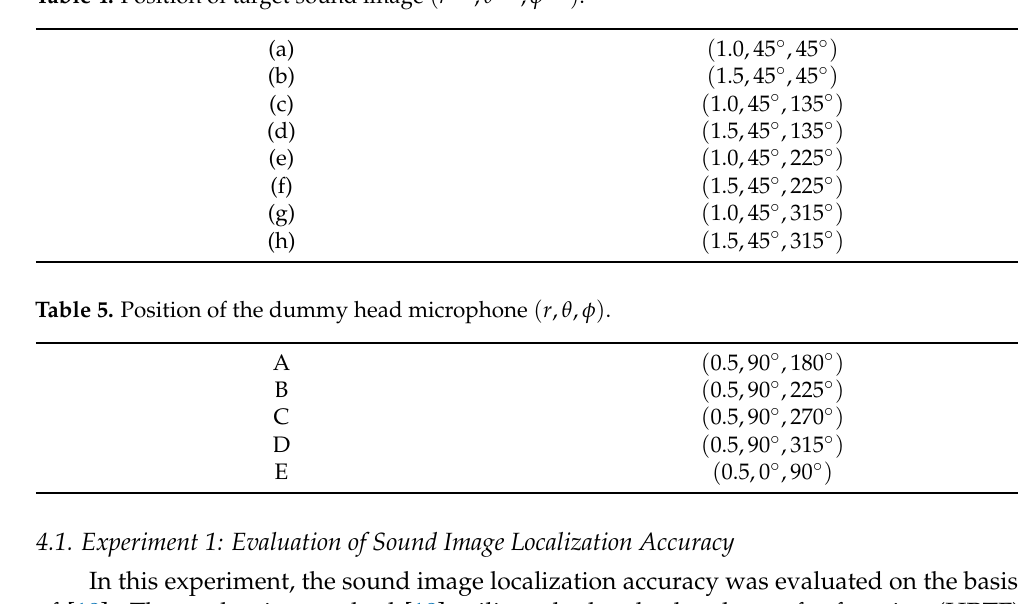
Table 4. Position of target sound image ( r Tar , θ Tar , φ Tar ) .